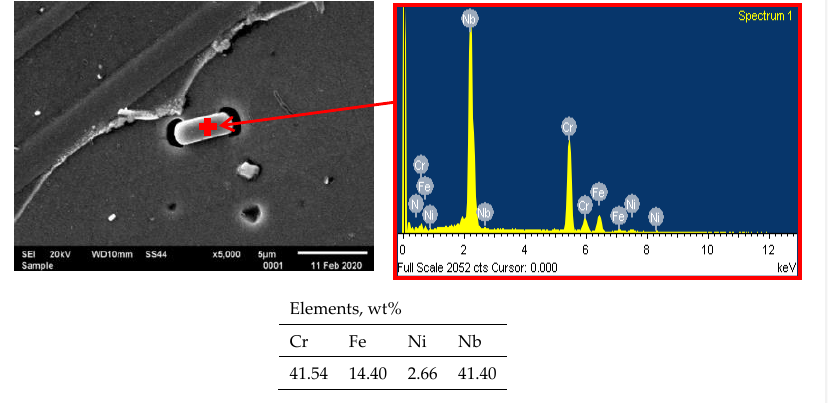
Figure 3. EDS analysis of precipitate inside the grain.